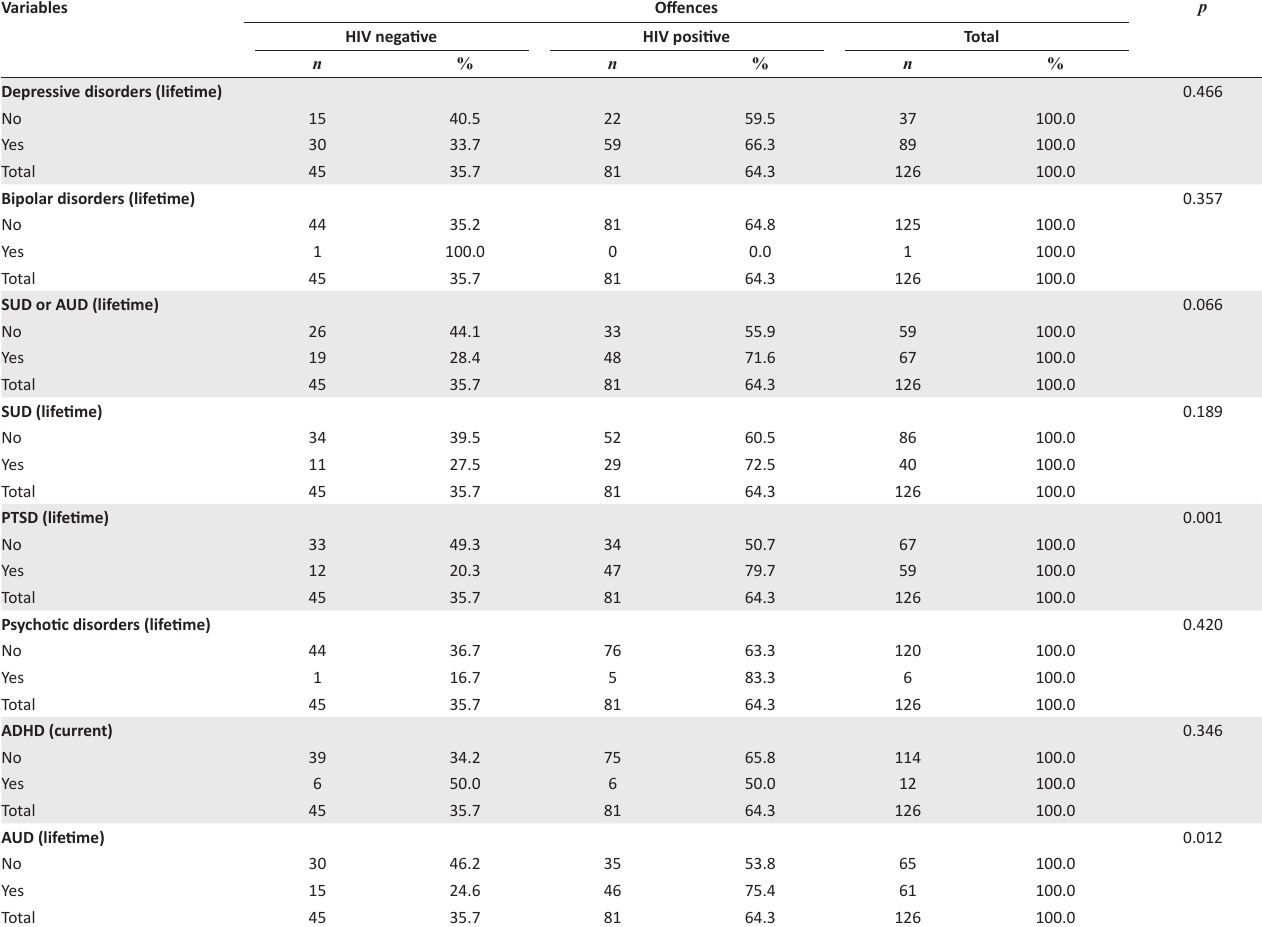
TABLE 3: Associations between HIV and mental illnesses.